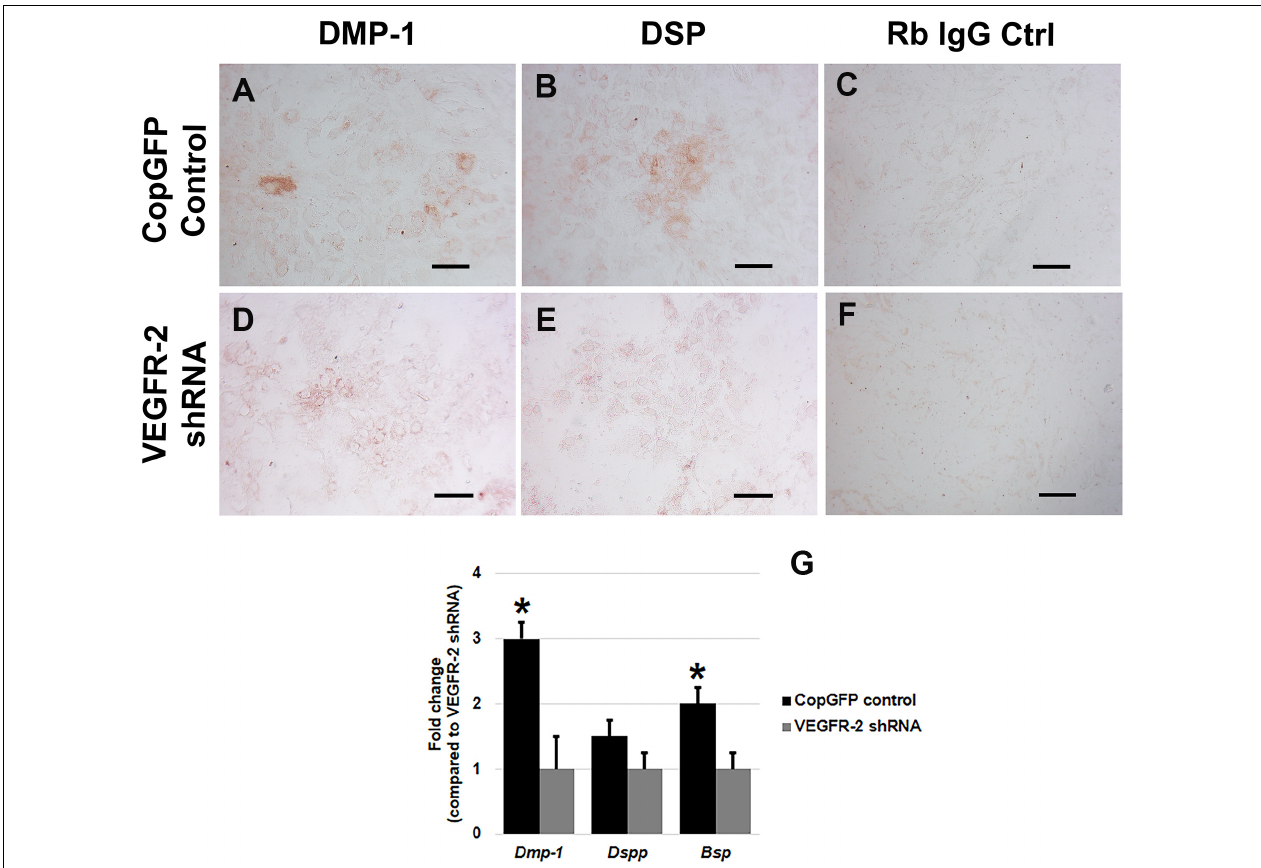
FIGURE 4 | Dentin matrix protein staining and osteo-odontogenic gene expression in CopGFP control and VEGFR-2 shRNA DPSCs after a culture in osteo-odontogenic BMP-2 media. Immunocytochemistry showed certain positive cells of anti-DMP-1 (A) and anti-DSP (B) staining (in brown) in differentiated CopGFP control DPSCs but slightly stained cells in VEGFR-2 shRNA DPSCs (D,E) . The rabbit IgG control (Rb IgG Ctrl) stained in CopGFP control (C) and VEGFR-2 shRNA DPSCs (F) were completely negative to confirm the specificity of antibodies. Scale bars indicate 100 µ m. The bar graph reveals that real-time PCR